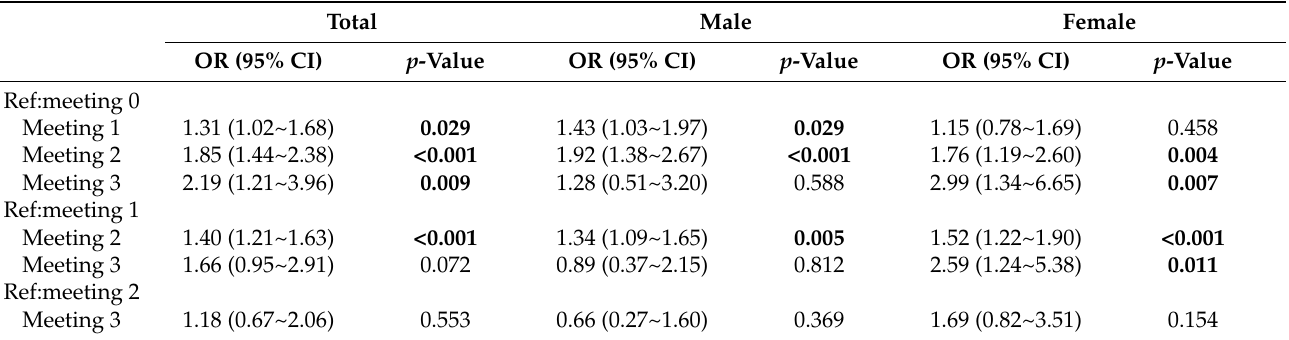
Table 3. The relationship between the number of 24-HMG recommendations met and physical health in the